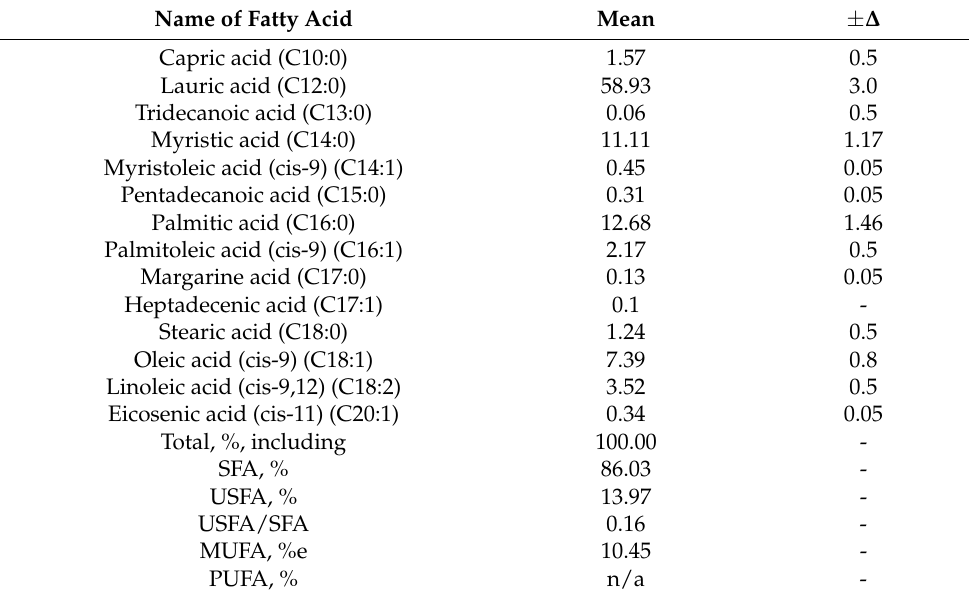
Table 4. The content of fatty acids in BSFLF (g/100 g of FAs).